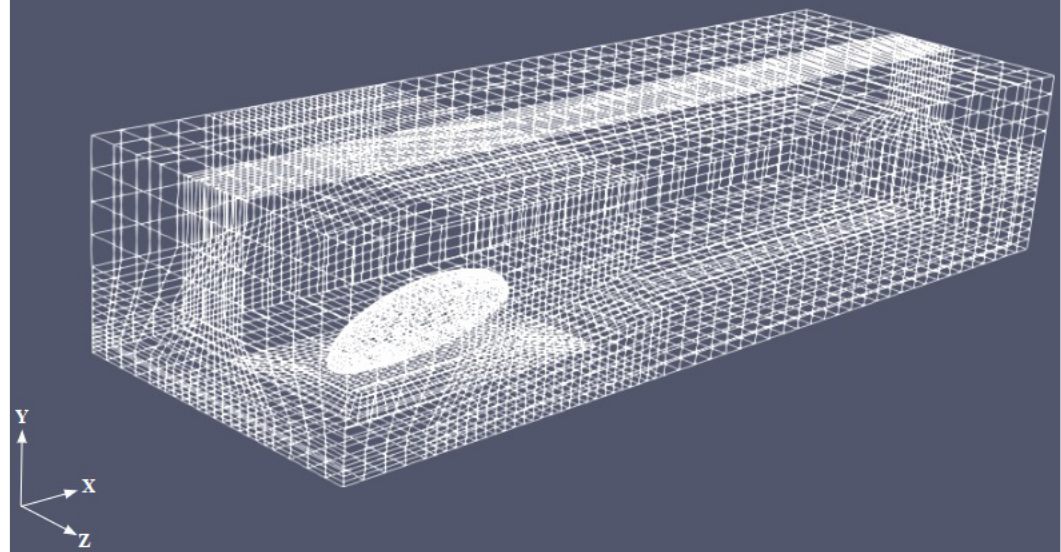
Figure 3. Sample computational mesh for α = 30 deg. The mesh is fully structured and multi-block, and features 2.5 × 10 6 grid cells. The cuboid surrounding the body has dimensions: L x = 20mm, L y = 8.5mm, and L z = 10mm. For ease of visualization, only one of every five grid cells is shown in this